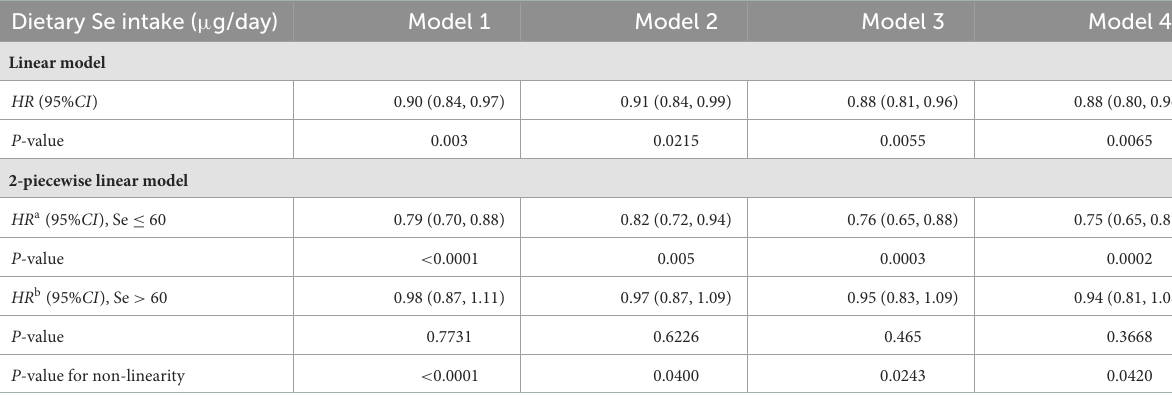
TABLE 3 Threshold effect of dietary selenium intake on risk of developing